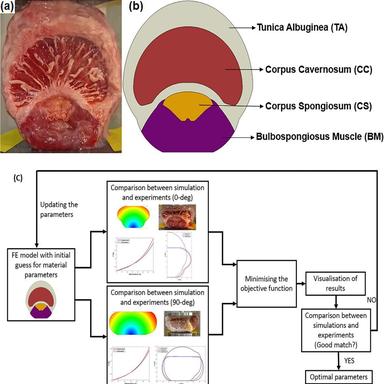
(a) Horse penis cross section, (b) the cross section approximated for FE simulation including four individual layers, (c) flowchart of the inverse FE algorithm.